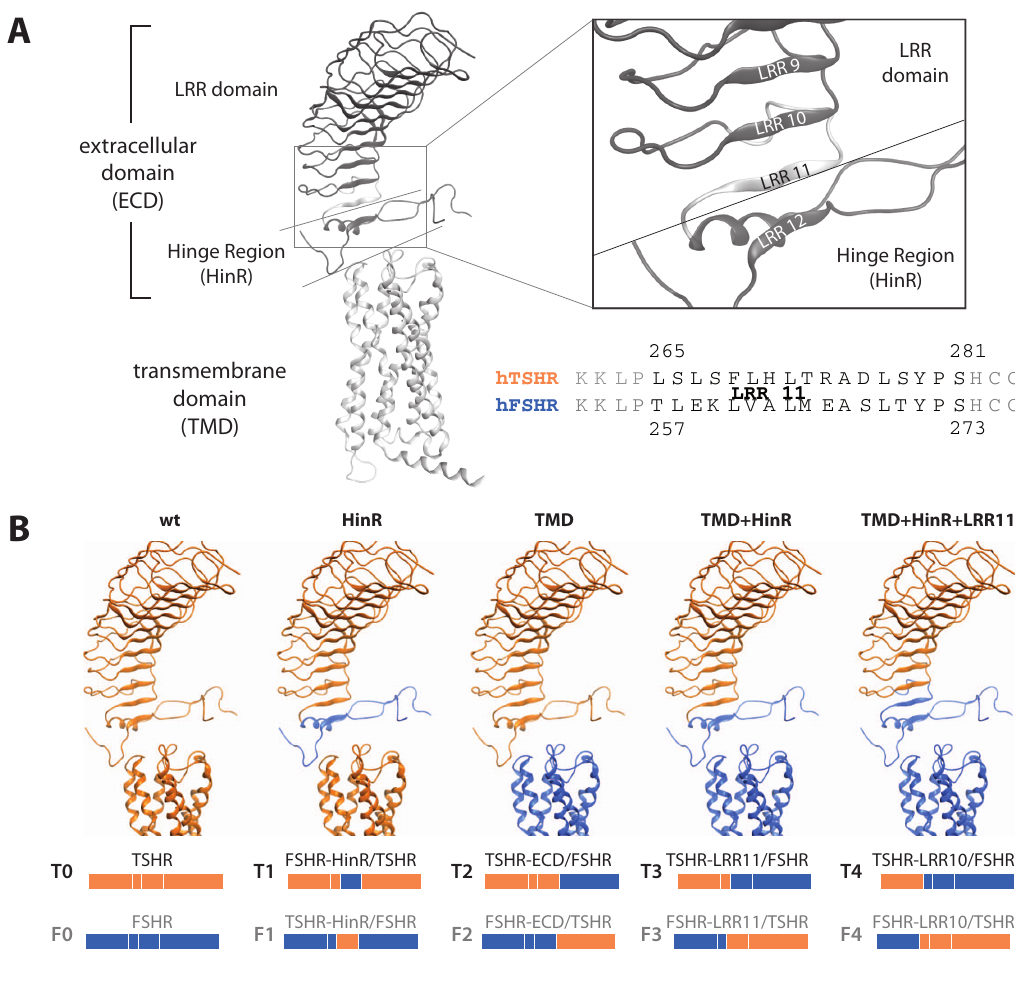
Figure 1. Components of glycoprotein hormone receptors (GPHRs) and composition of the generated receptor chimeras. A: GPHRs consist of a transmembrane domain common to all GPCR and an extracellular domain (ECD), which can be further subdivided into a leucine-rich repeat (LRR) domain and the hinge region (HinR). Previous crystal structures included only the first 10 LRRs. The Alignment shows the protein sequence of the 11 th LRR of the TSHR and the FSHR, which can, based on the chosen HinR definition, considered to be part of the LRR domain or the HinR. B: Composition and terminology of the receptor chimeras. The structural representation shows the chimeras including the LRR domain of the TSHR. Components with TSHR protein sequence are colored in orange and components with FSHR protein sequence are colored in blue.